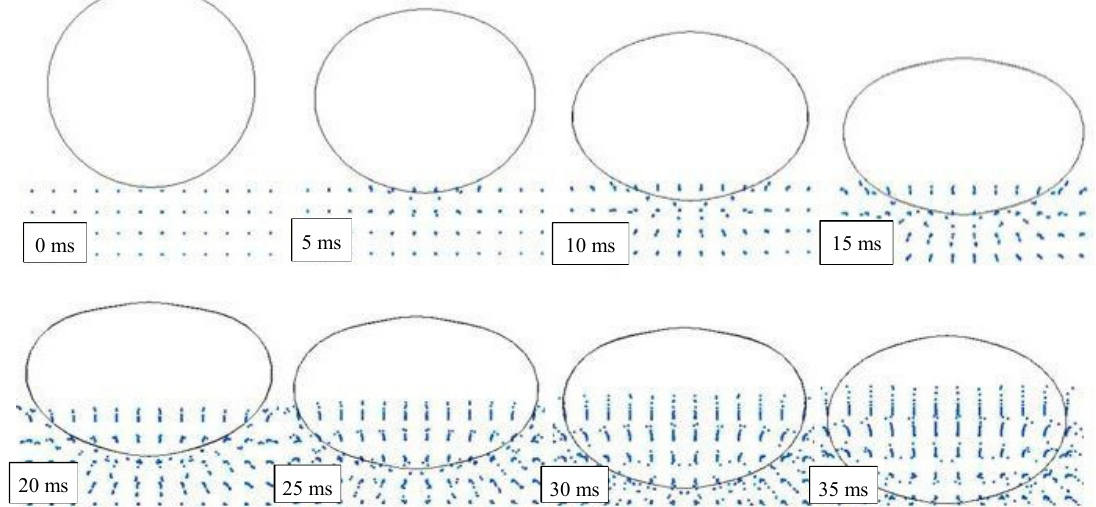
Figure 8. Impact numerical results without considering the air effect (drop height of 1500 mm).